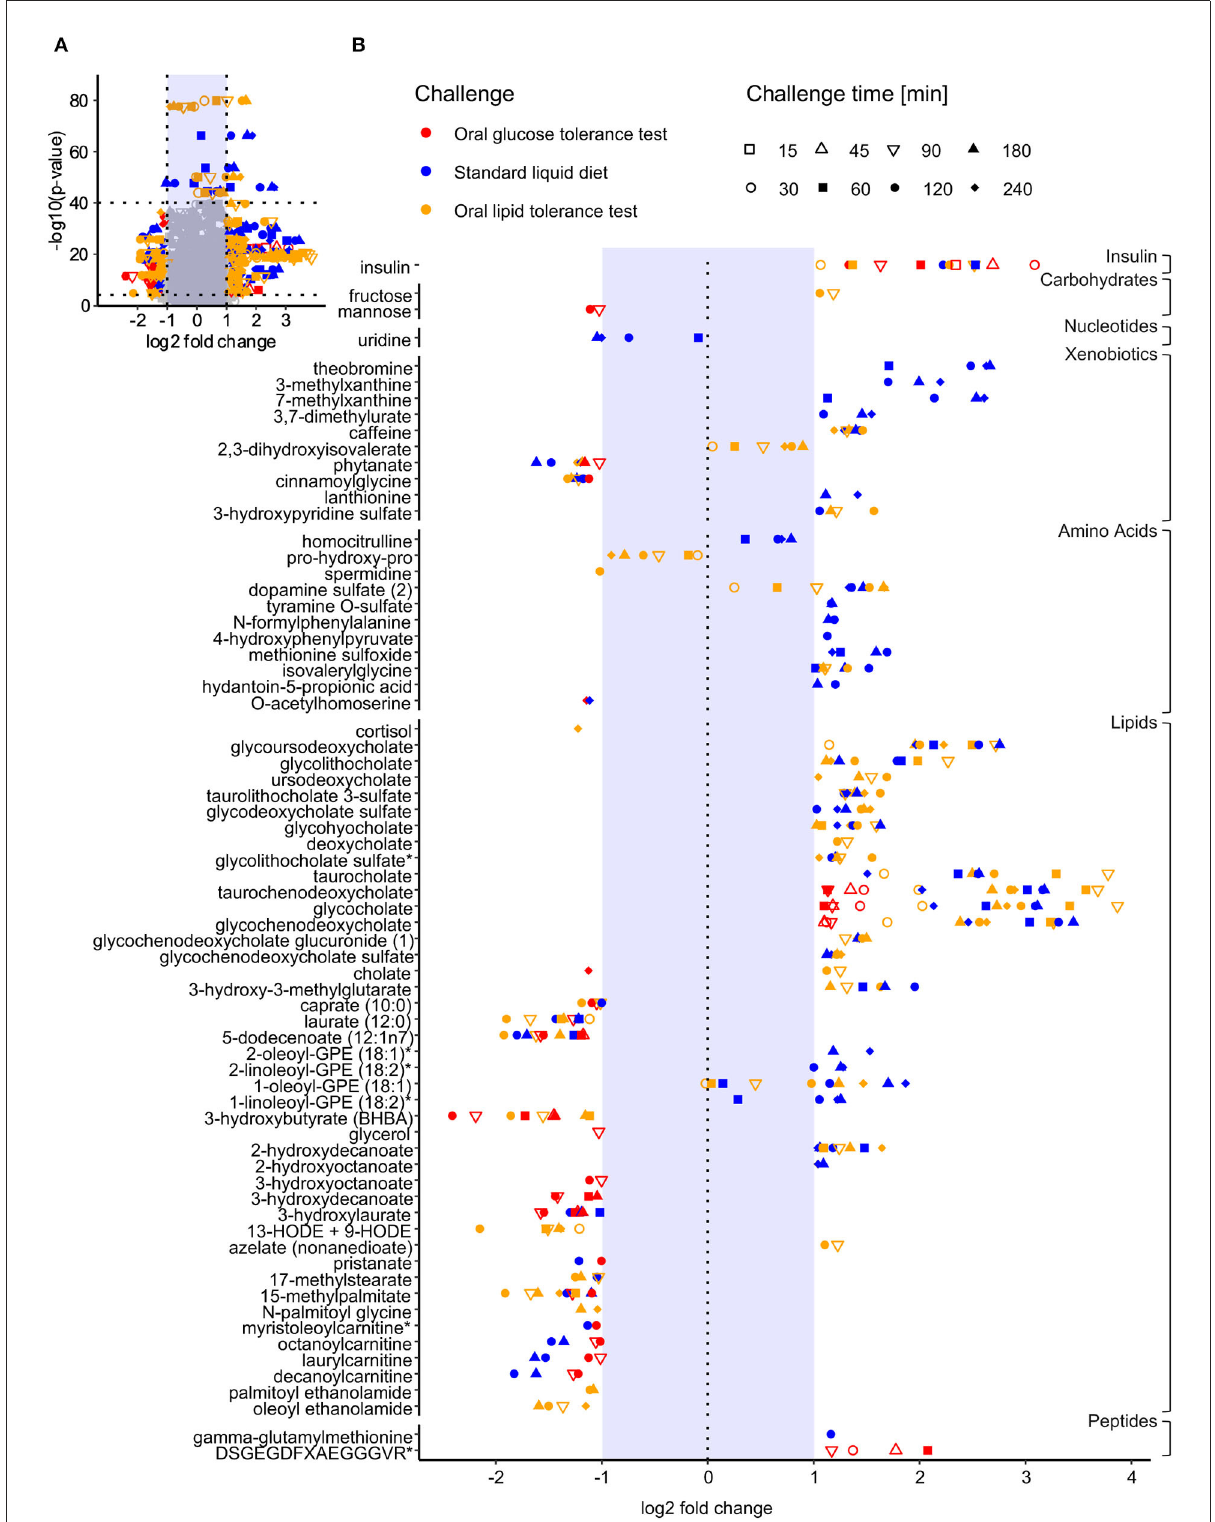
FIGURE2 Fold changes of metabolites at different sampling time points after ingestion for results with largest effects/smallest p -values. (A) Volcano plot showing the log 2 fold change of each metabolite in each challenge after each sampled time point (time points are indicated by